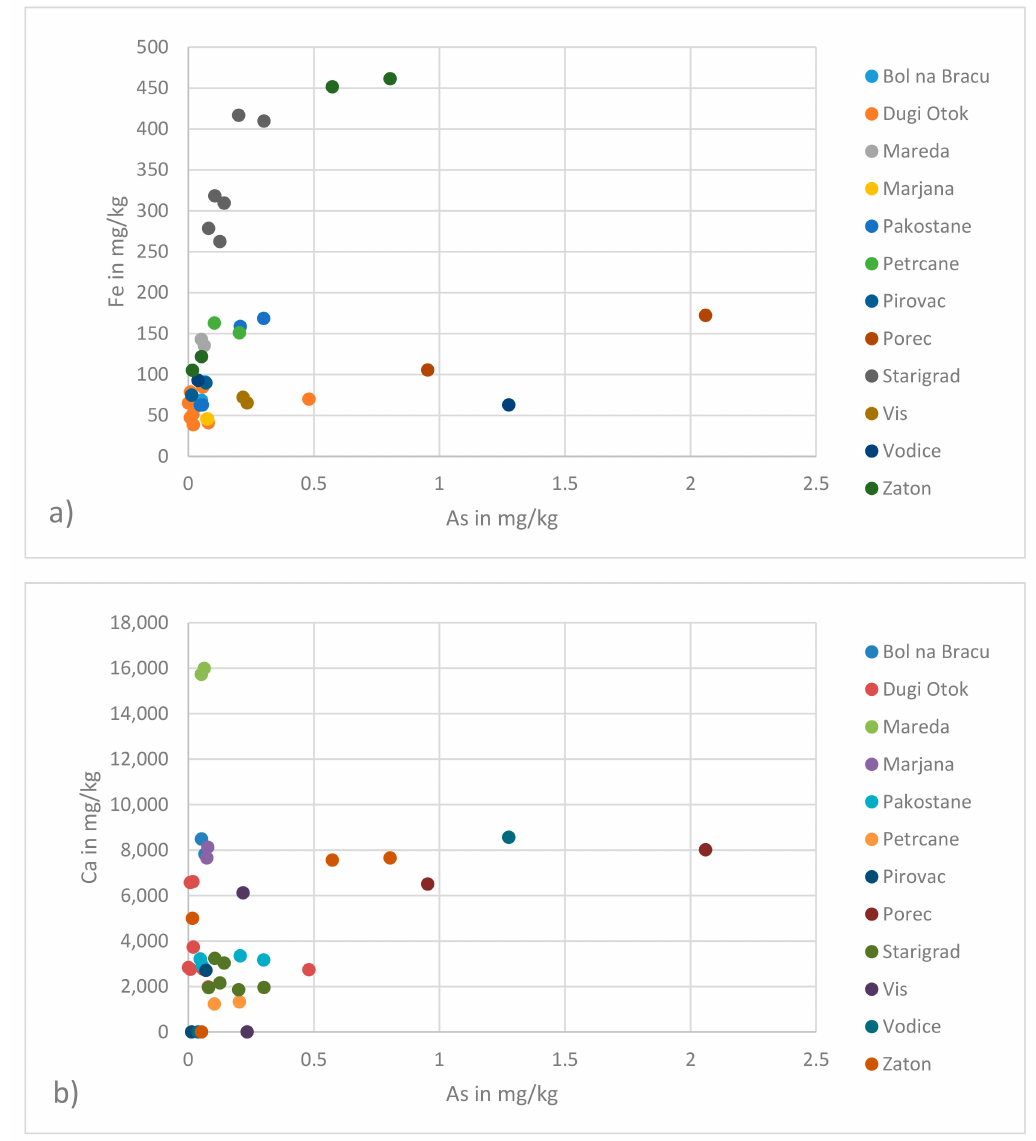
Figure 1. Correlation of needle contents of selected soil background elements: ( a ) Fe vs. As; and ( b ) Ca vs.